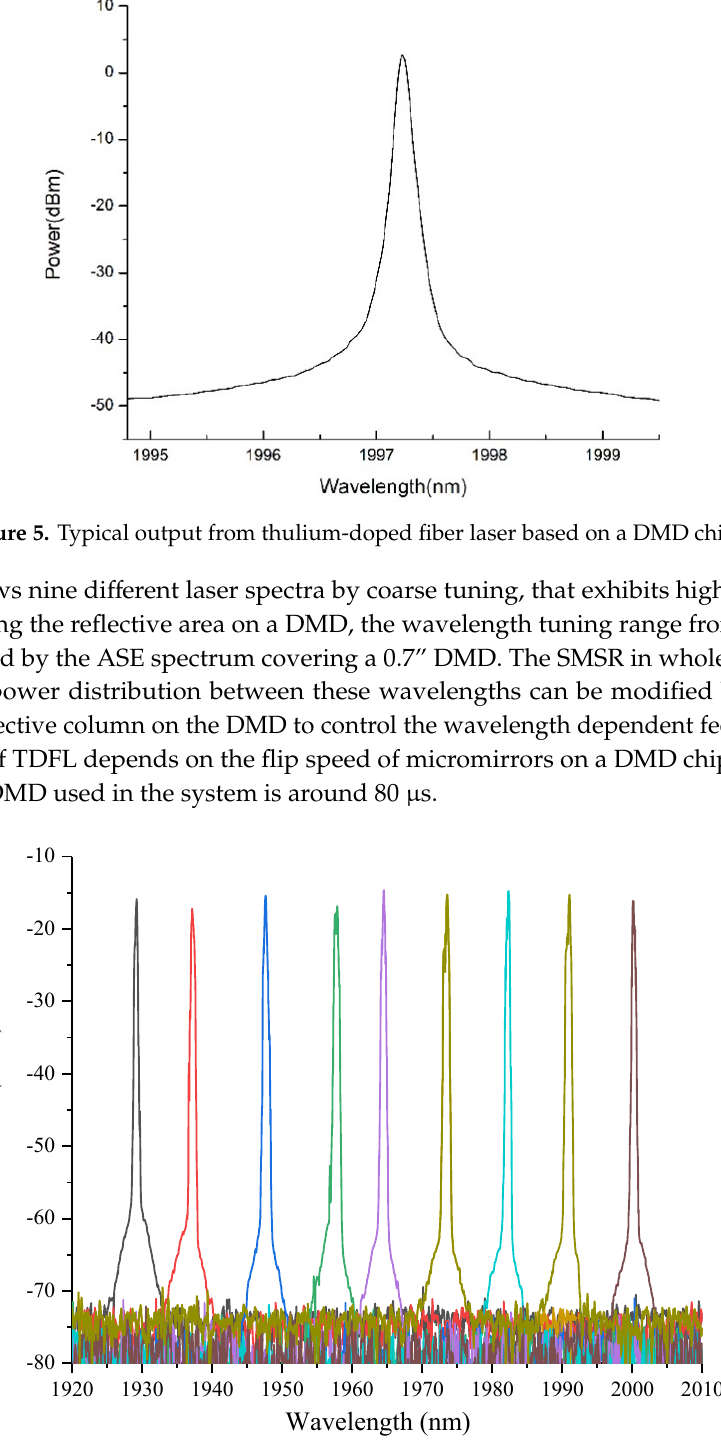
Figure 6. Output signal from thulium-doped fiber laser by coarse-tuning.